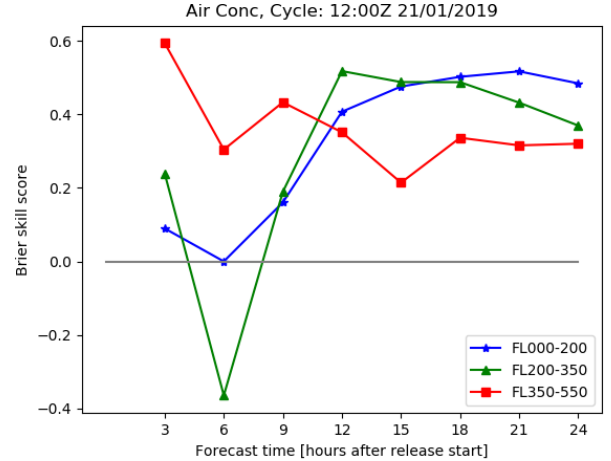
Figure 11. Brier skill score changes with time since the start of the eruption for a simulation with a high Brier score. This is for the same case as Fig.